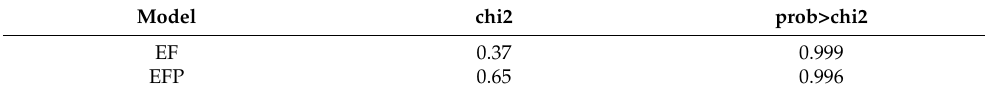
Table 5. Hausman-type test.